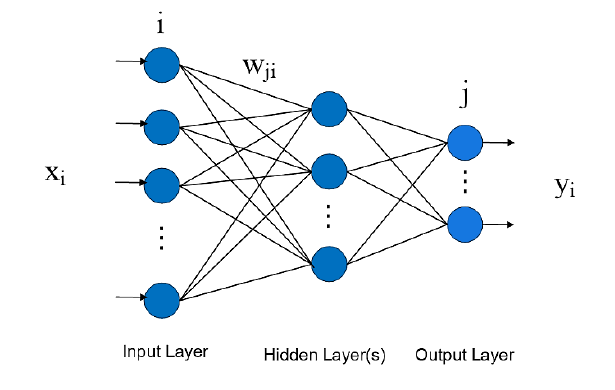
Fig. 3 . Architecture of a